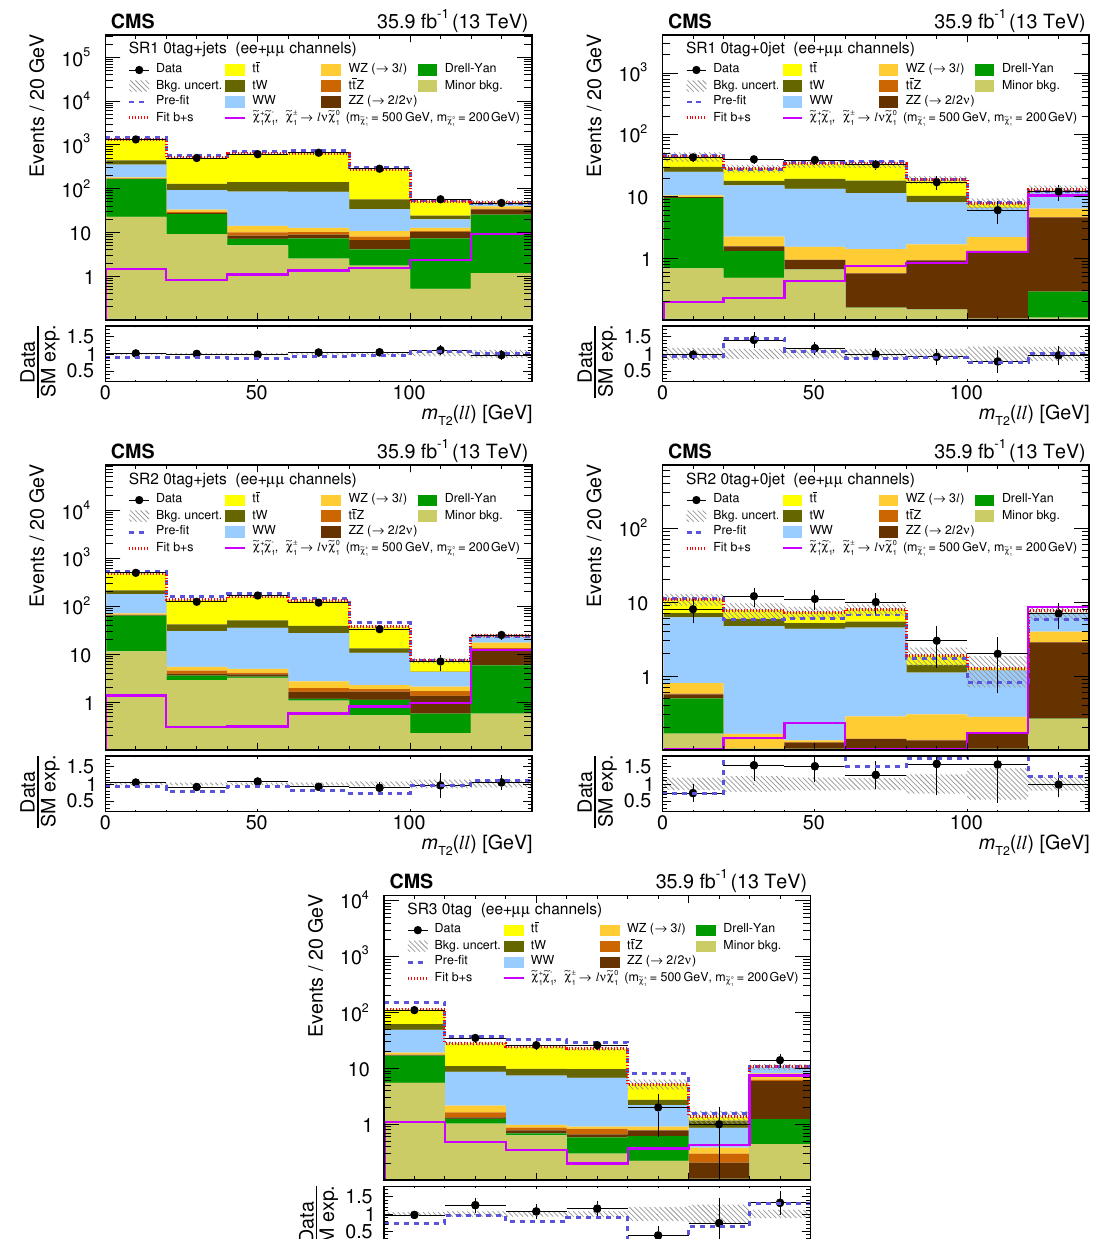
Figure 5 . The same distributions of m